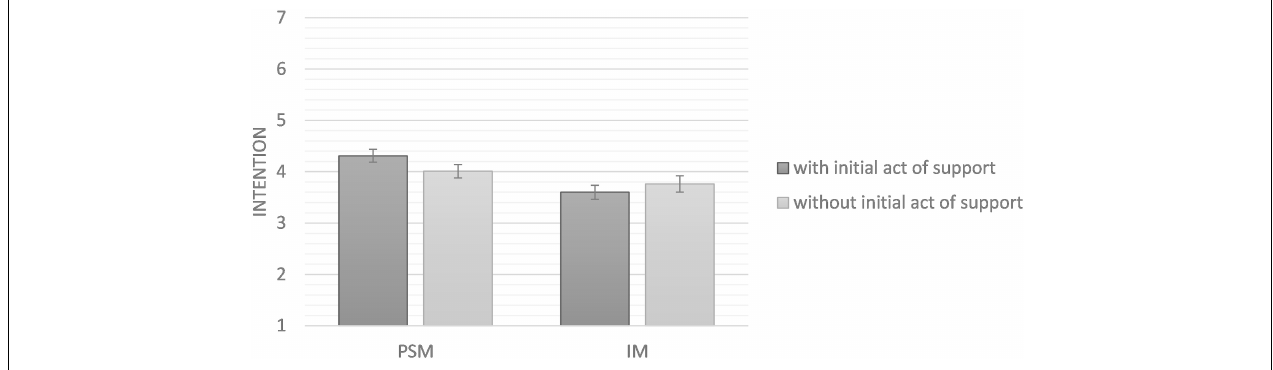
FIGURE 3 | Means of intention to donate blood as a function of experimental conditions (Study 2). Error bars represent standard